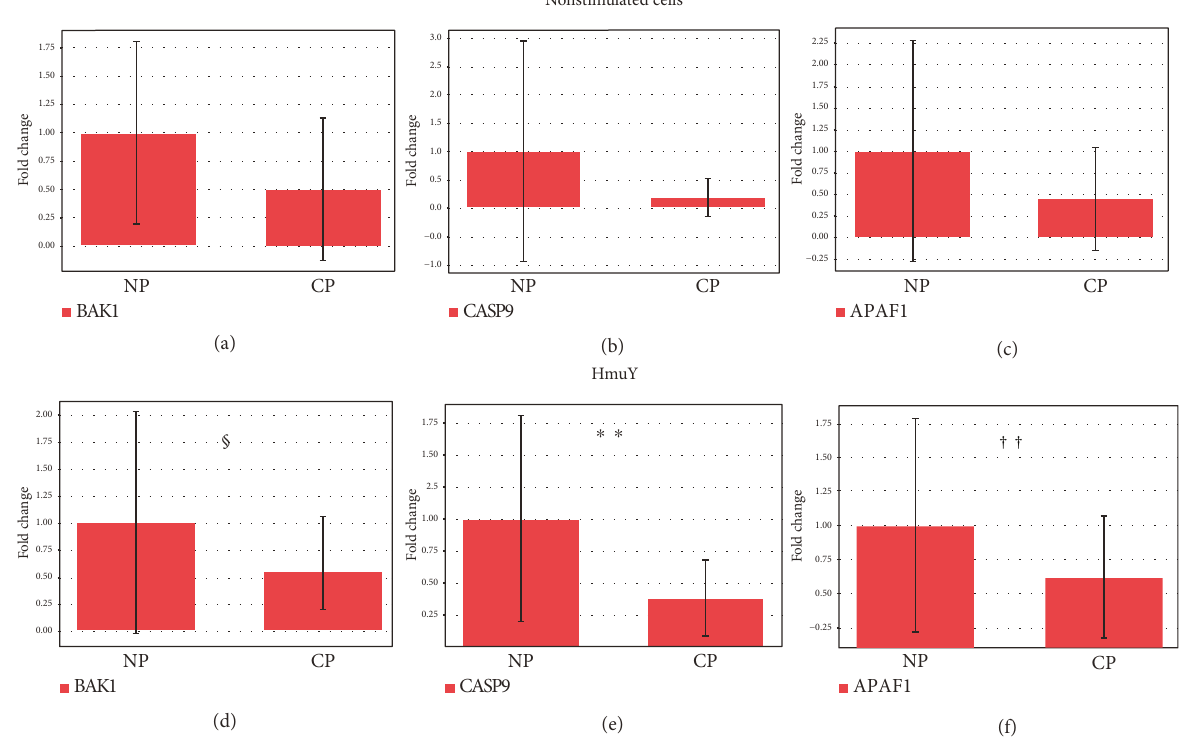
Figure 3: Apoptosis-related intrinsic pathway gene expression in the PBMC of the (a-c) P and NP groups without stimuli and under (d-f) P. gingivalis HmuY protein stimulation. (a, d) BAK1 (BCL2-antagonist/killer 1); (b, e) CASP9 (caspase 9); (c, f) APAF1 (apoptotic peptidase activating factor-1). ∗∗ p = 0 01 , †† p = 0 05 , and § p < 0 1